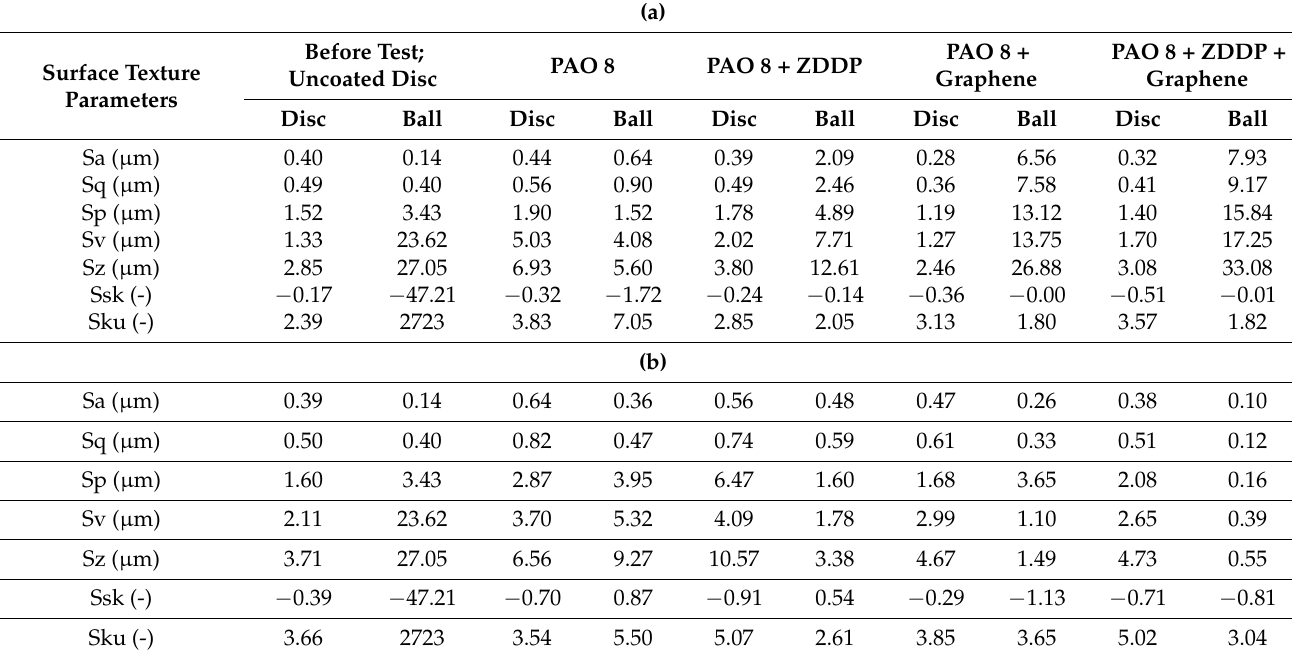
Table 6. Surface texture parameters for ( a ) the uncoated steel discs and ( b ) the W-DLC -coated steel discs in contact with the steel balls before and after the tribological tests.